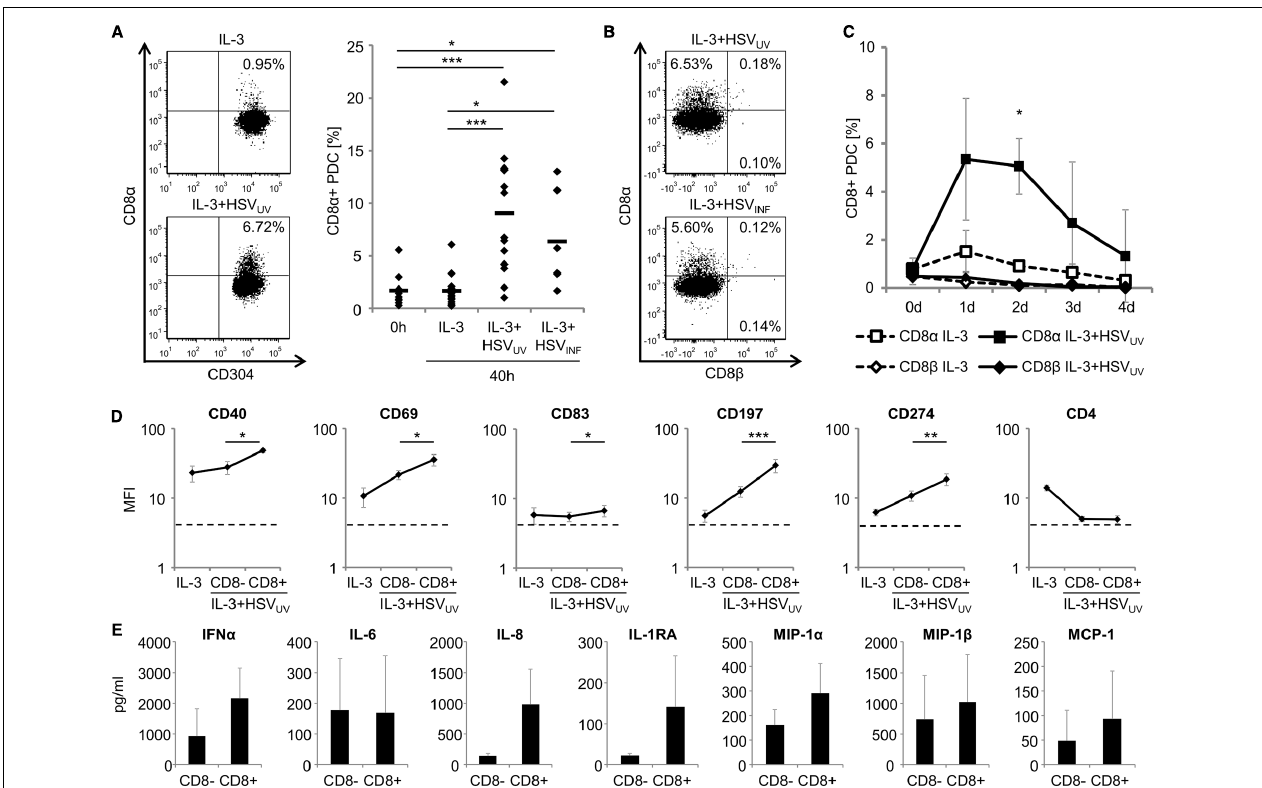
FIGURE 1 | Characterization of CD8 a -expressing human plasmacytoid dendritic cells (PDC). (A) Expression of CD8 a on human PDC, as evaluated by flow cytometry within PBMC immediately after cell isolation (0 h) ( n = 9) and after cultivation of purified PDC in the presence of IL-3 (10 ng/ml), IL-3 plus UV-inactivated herpes simplex virus type 1 (HSV UV ) ( n = 16) or infectious HSV-1 (HSV INF ) ( n = 6) (1 (cid:2) 10 6 plaque-forming units/ml) for 40 h. One representative example of PDC exposed to IL-3 (upper left panel) and IL-3 plus HSV UV (lower left panel) and data of all donors including mean values (bars) are shown (right panel). (B) Representative expression of CD8 a , not CD8 b , on human PDC after exposure to IL-3 plus HSV UV (upper panel, n = 4) or HSV INF (lower panel, n = 3) for 40 h. (C) Kinetics of CD8 a ( n = 4) and CD8 b ( n = 3) expression after exposure of human PDC to IL-3 or IL-3 plus HSV UV for 4 days. Data are presented as mean and standard deviation. (D) Expression of markers for costimulation (CD40, CD274), activation (CD69), maturation